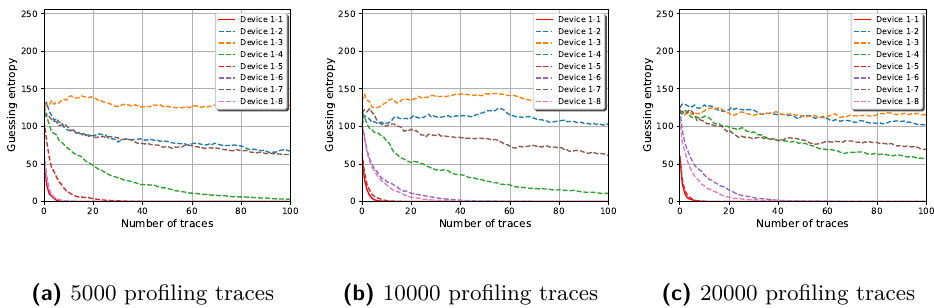
Figure 10: Influence of the number of profiling traces on pre-trained models.